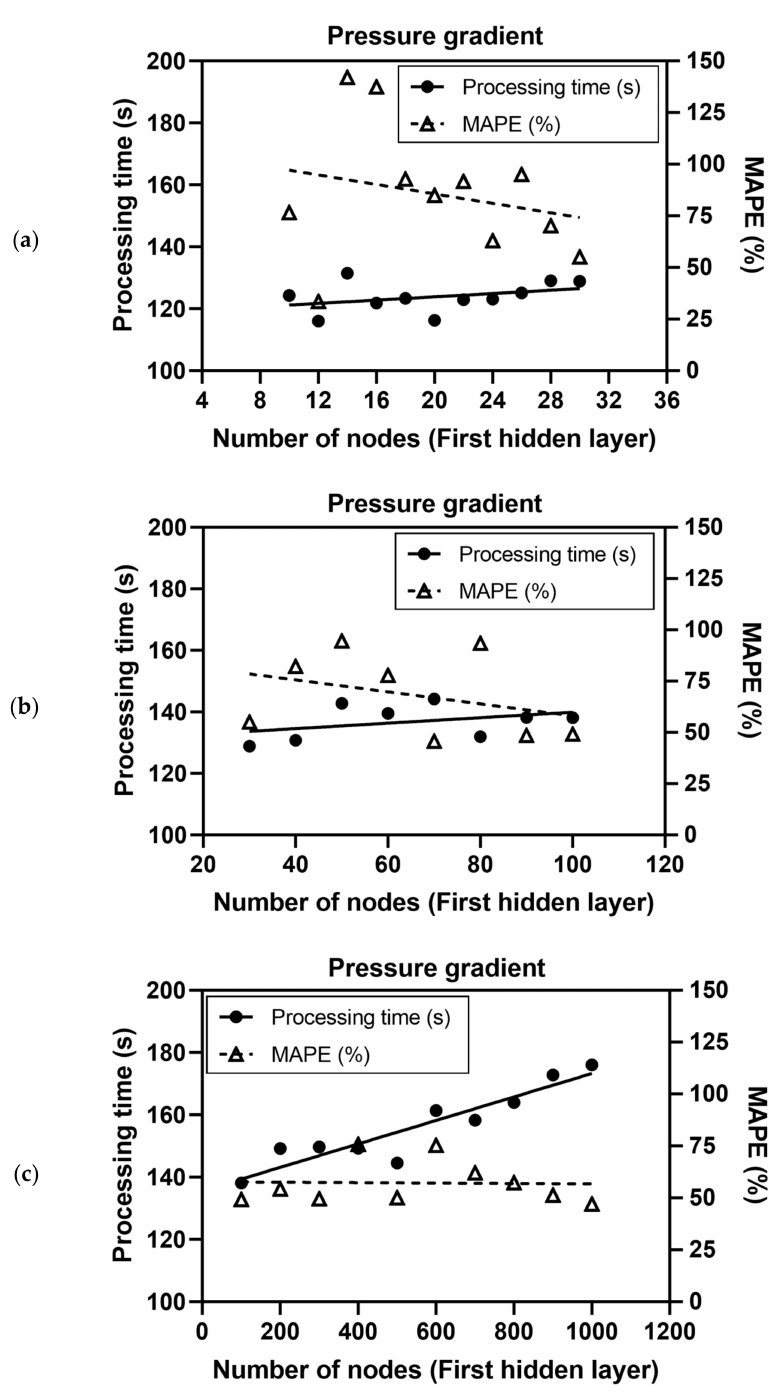
Figure 4. Processing time and training accuracy of pressure gradients (Pa / m) for the validation data (31 data points) in relation to the number of nodes in the first hidden layer ( H DNN1 ) in the range of ( a ) 10 to 30, ( b ) 30 to 100, and ( c ) 100 to